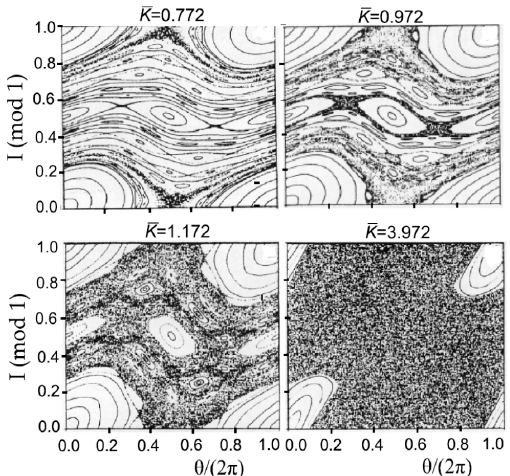
Figure 7. Phase space trajectories of a kicked rotor with Hamiltonian (12) (adopted from [26]).